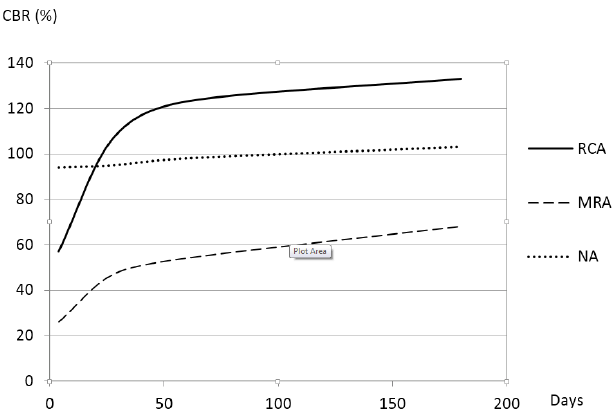
Figure 4. CBR evolution in soaked conditions.